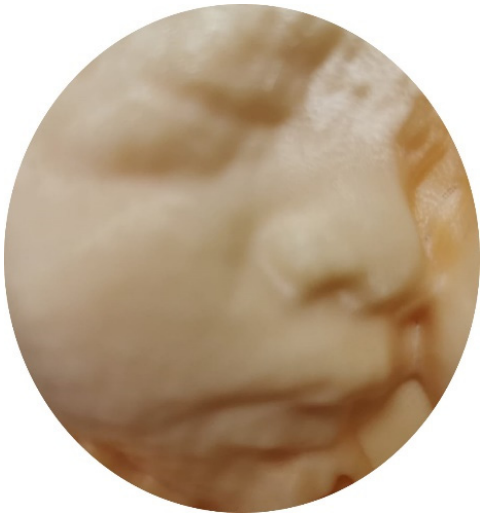
Figure 12. A physical model of three-dimensional printing of the fetal